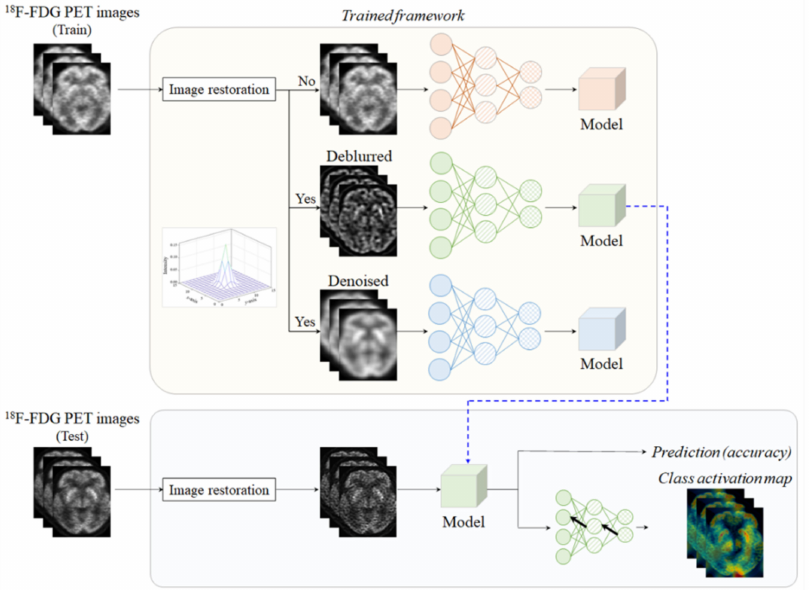
Figure 4. Simplified diagram representing the proposed prediction process incorporating image restoration using the deep convolutional neural network trained using 18 F-FDG PET images.